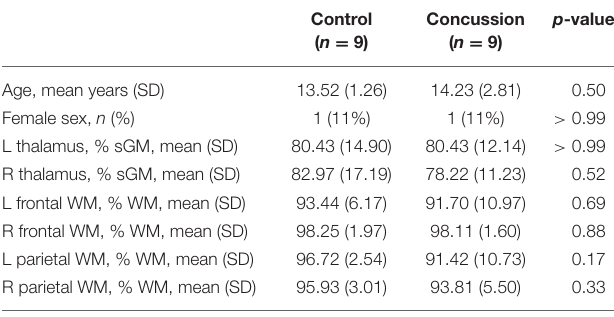
TABLE 1 | Demographics and ROI partial